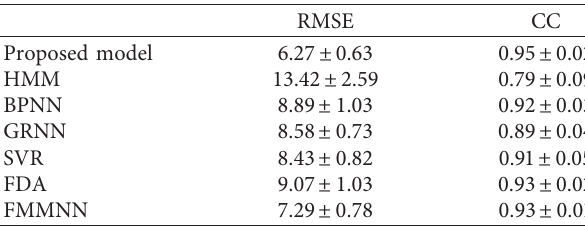
Figure 10: Mean RMSE and CC of seven regression models. Table 3: Evaluation of the performance of the proposed model (RMSE: root mean square error, CC: correlation